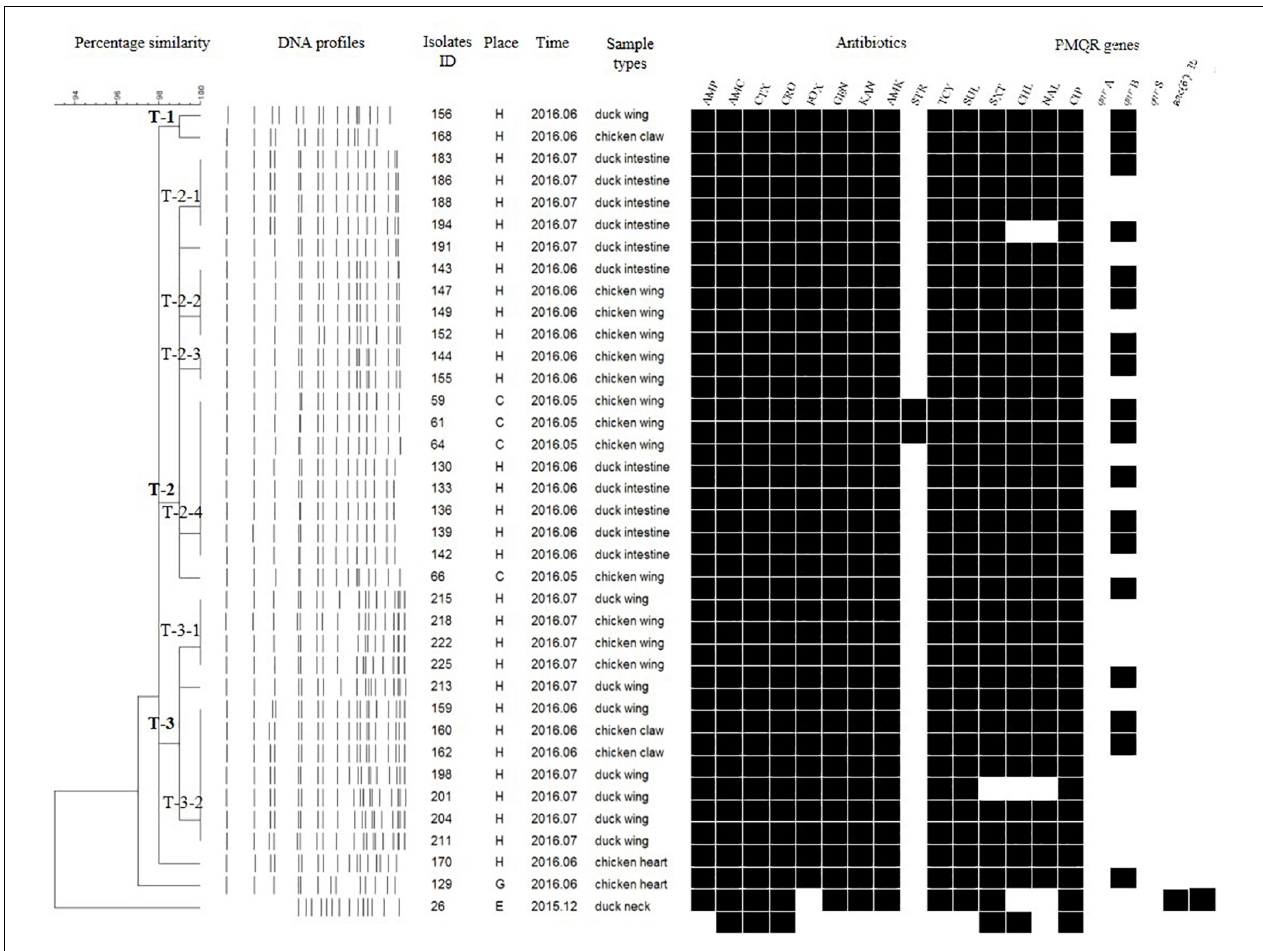
FIGURE 2 | Dendrogram of pulse-field gel electrophoresis (PFGE) profiles for 36 S. Thompson isolates, their antibiotic resistance, and plasmid-mediated quinolone resistance (PMQR) genes. Antibiotics: Ampicillin (AMP), Amoxicillin-clavulanic acid (AMC), Ceftiofur (CTX), Ceftriaxone (CRO), Cefoxitin (FOX), Gentamicin (GEN), Kanamycin (KAN), Amikacin (AMK), Streptomycin (STR), Tetracyclines (TCY), Sulfisoxazole (SUL), Trimethoprim/sulfamethoxazole (SXT), Chloramphenicol (CHL), Nalidixic acid (NAL), and Ciprofloxacin